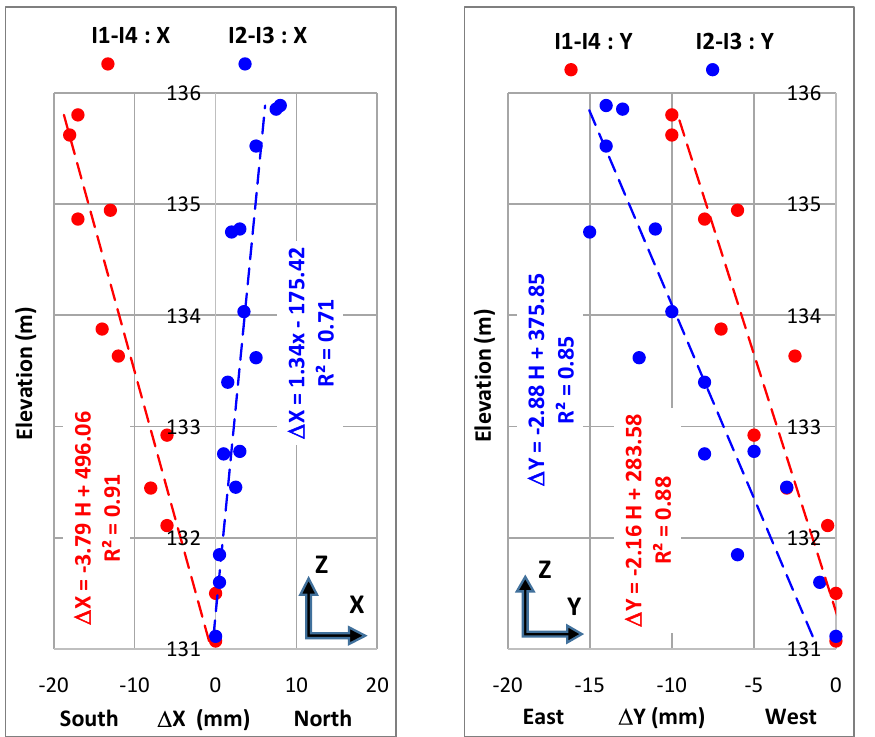
Figure 9. Linear interpolation of observed points on tower lining [9]. Linear interpolation of observed points on the tower edges show the inclination, namely the lining I1–I4 of the south tower to the south by θ X = 3.79 mm/m, and the lining I2–I3 of the north tower to the north by θ X = 1.33 mm/m, or divergence of 5.12 mm/m. At the same time, both towers lean to the east about θ Y = 2.16–2.88 mm/m. At the height of the crown of the frontage wall at 27.0 m (elevation 137.5 m), the spacing of the towers is about X = 27 × 0.512 = 13.8 cm, which is slightly less than 15 cm, which is approximately the sum of the measured cracks width at the crown of the frontage wall.